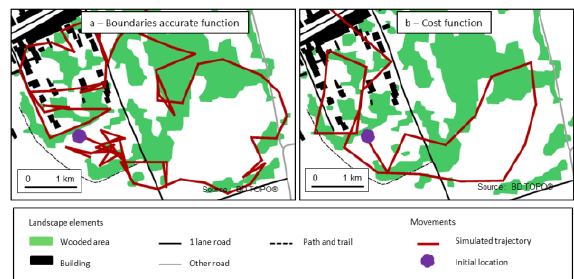
Figure 6. Two trajectories constructed with the two simulation functions, extraction concerning one hour. We notice that the one built from the boundaries accurate function (a) is more sinuous than the one build with the cost function (b).